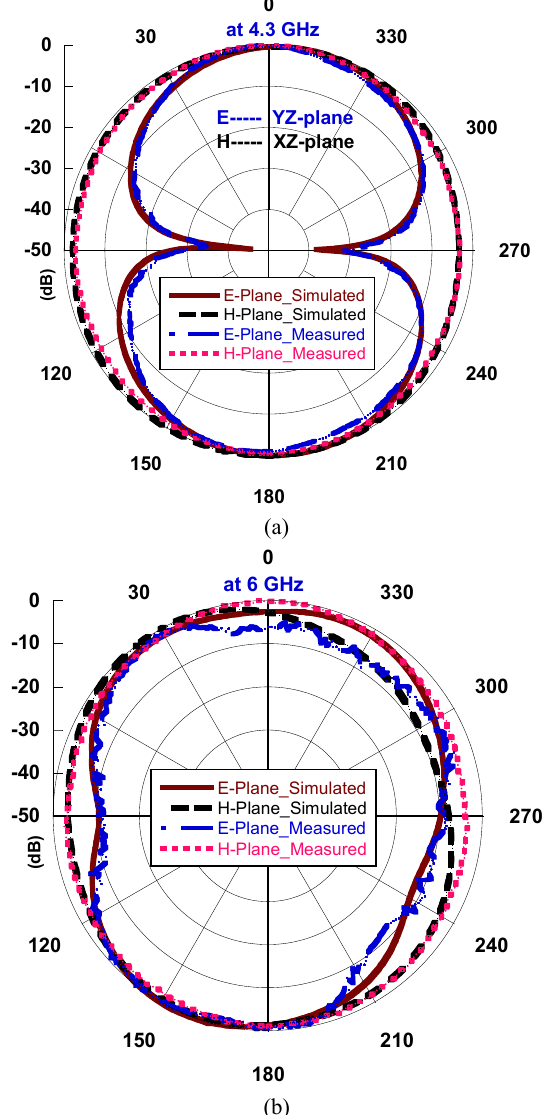
Figure 5. The radiation patterns of the prototype at C = 0.6 pF. (a) dominant-mode at 4.3 GHz. (b) even-mode at 6